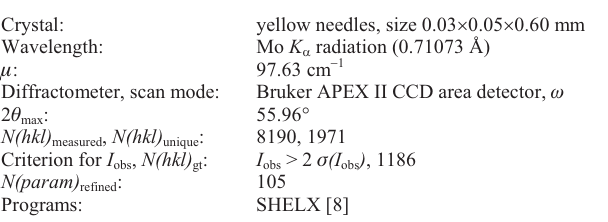
Table 1. Data collection and handling.